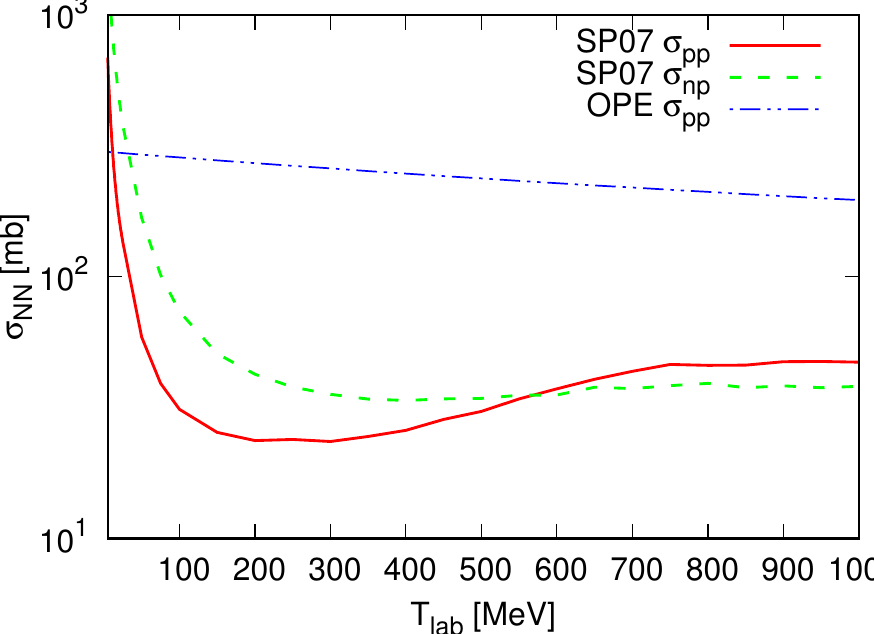
Figure 3 . The SP07 global (cid:12)ts for the total pp (solid) and np (dashed) elastic scattering cross sections as a function of the laboratory kinetic energy T lab , reported in ref. [73]. Also plotted is the total pp elastic cross section obtained using the one-pion exchange (OPE) approach (dash-double- dotted), with the pion mass term m (cid:25) in the braces